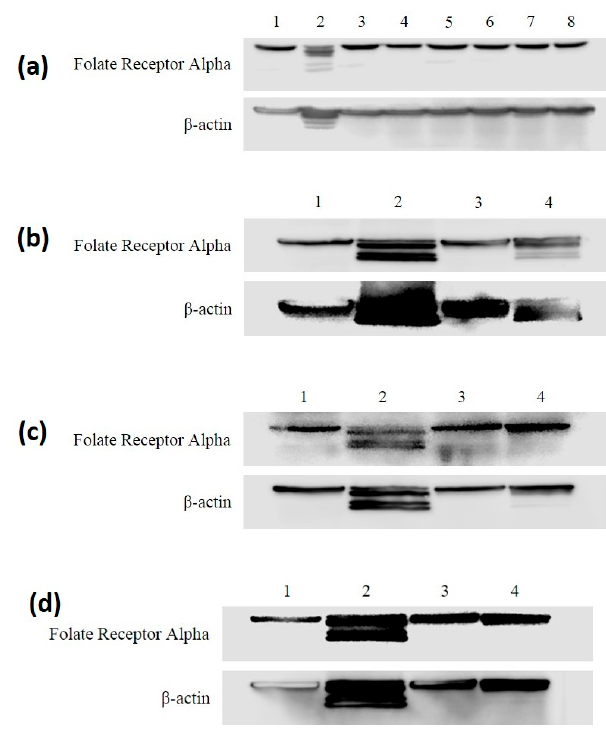
Figure 4. Western blot analysis of the Folate Receptor Alpha in MDA-MB-468 and HME50-5E cells treated with Selenite, Folic Acid, and Selenofolate. Immunoblotting was performed on whole cell lysates with the anti-Folate Receptor Alpha (FRA) or anti β -Actin antibodies followed by horseradish peroxidase conjugated rabbit anti-mouse antibodies and visualized with the SuperSignal™ West Femto Maximum Sensitivity detection system. ( a ) MDA-MB-468 and FRA: Lane 1: control, Lane 2: selenite 4 µM (2 µg Se) treatment, Lane 3: Folic Acid 50 µM treatment, Lane 4: Folic Acid 75 µM